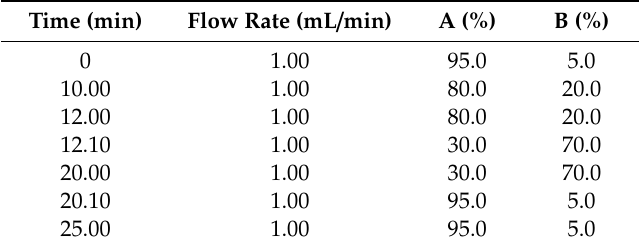
Table 2. HPLC gradient conditions of Salbutamol, Ipratropium bromide, and Budesonide and of Salbutamol, Ipratropium bromide, and Beclomethasone. Time